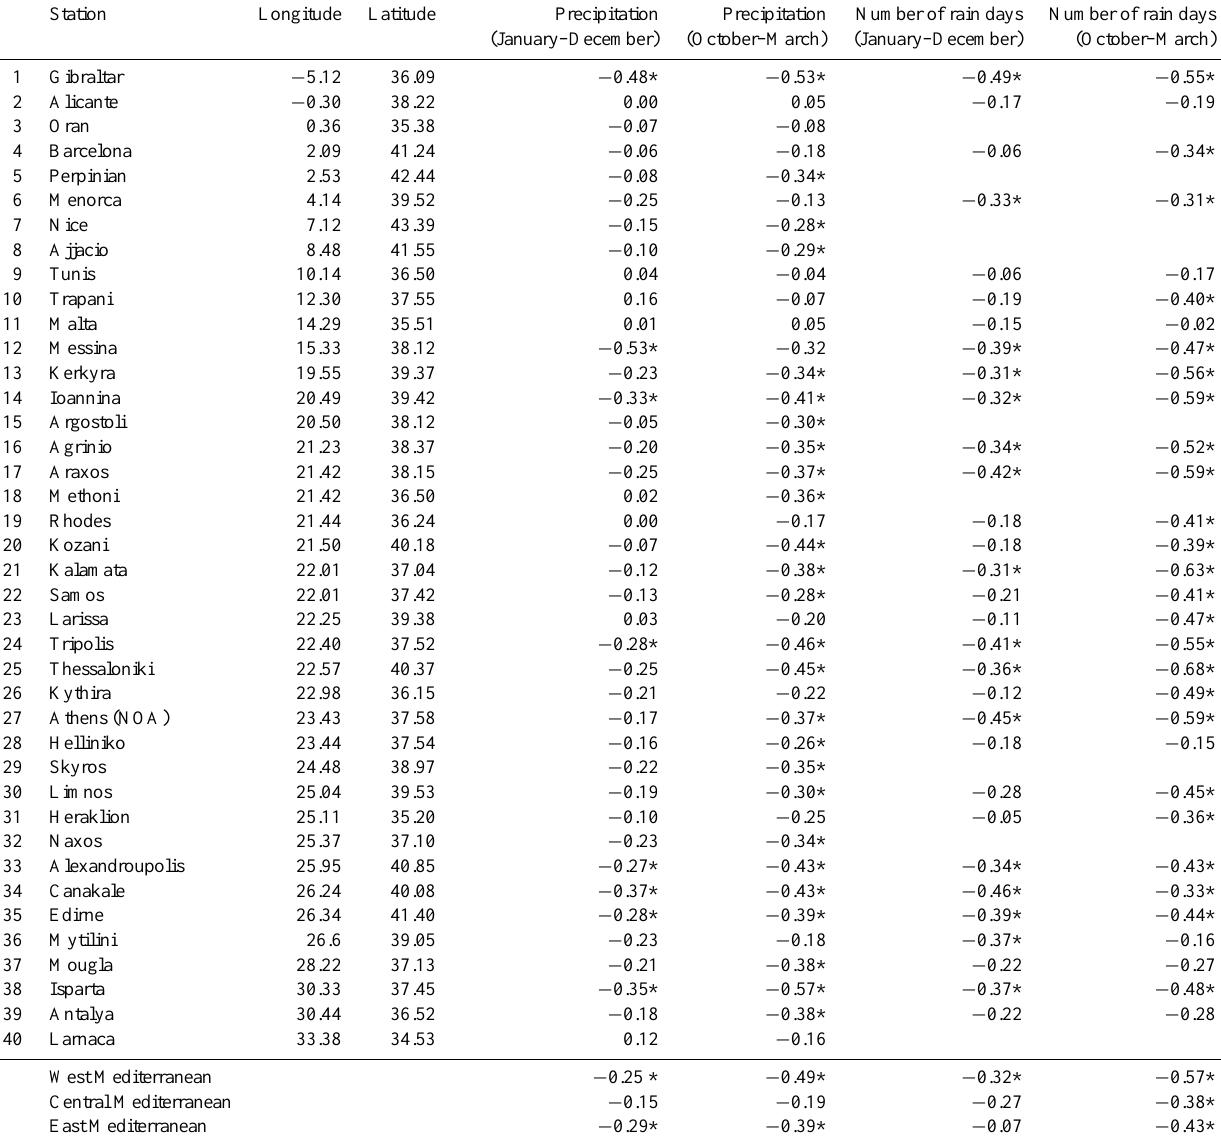
Table 2. Correlation coefficients of NAOI with precipitation totals (1951–2010) and number of rain days (1965–2010) for the entire year (January-December) and the rain season (October–March). The asterisk (*) denotes statistically significant figures at 95% confidence level.